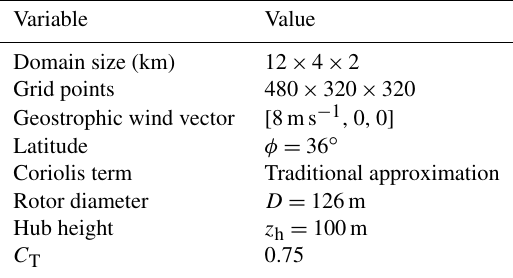
Table 1. Diurnal cycle large eddy simulation